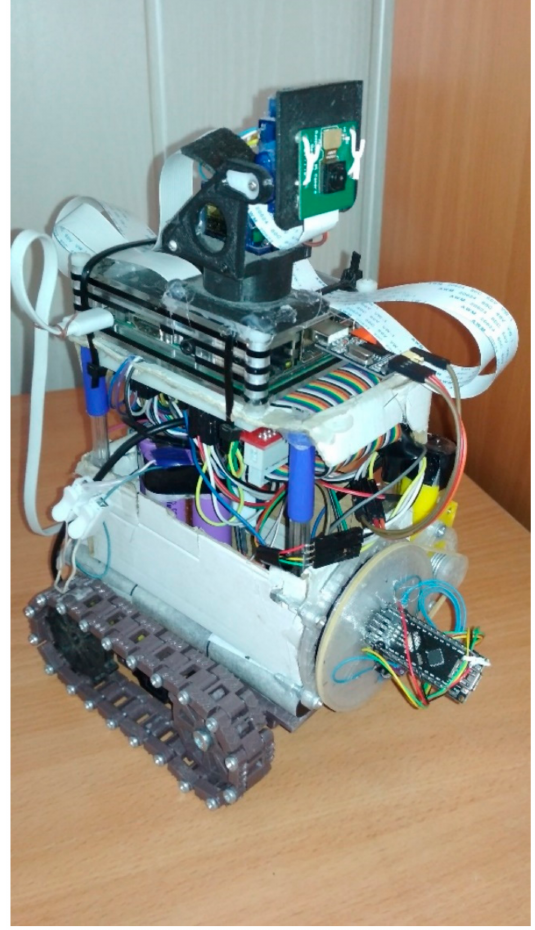
Figure 8. Mining explorer robot